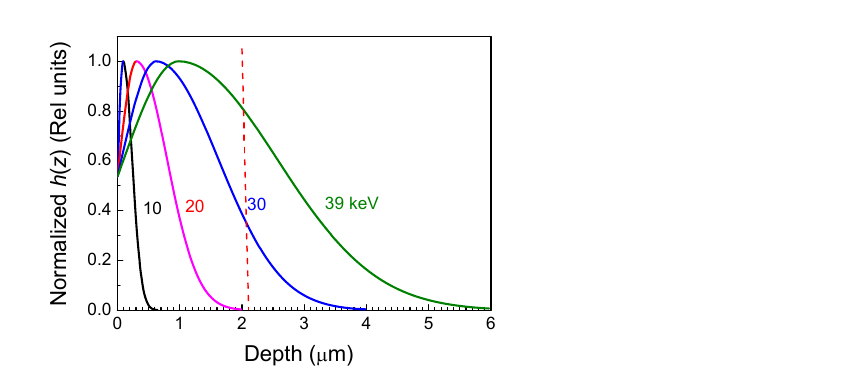
Figure 5. ( a ) Experimental C-V characteristic, ( b ) modeled 1/C 2 versus V for three donor concentrations.